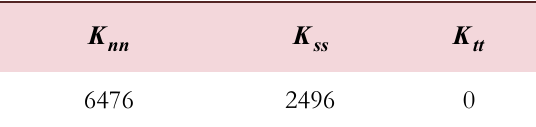
Table 2: CZM initial stiffness values set in FE